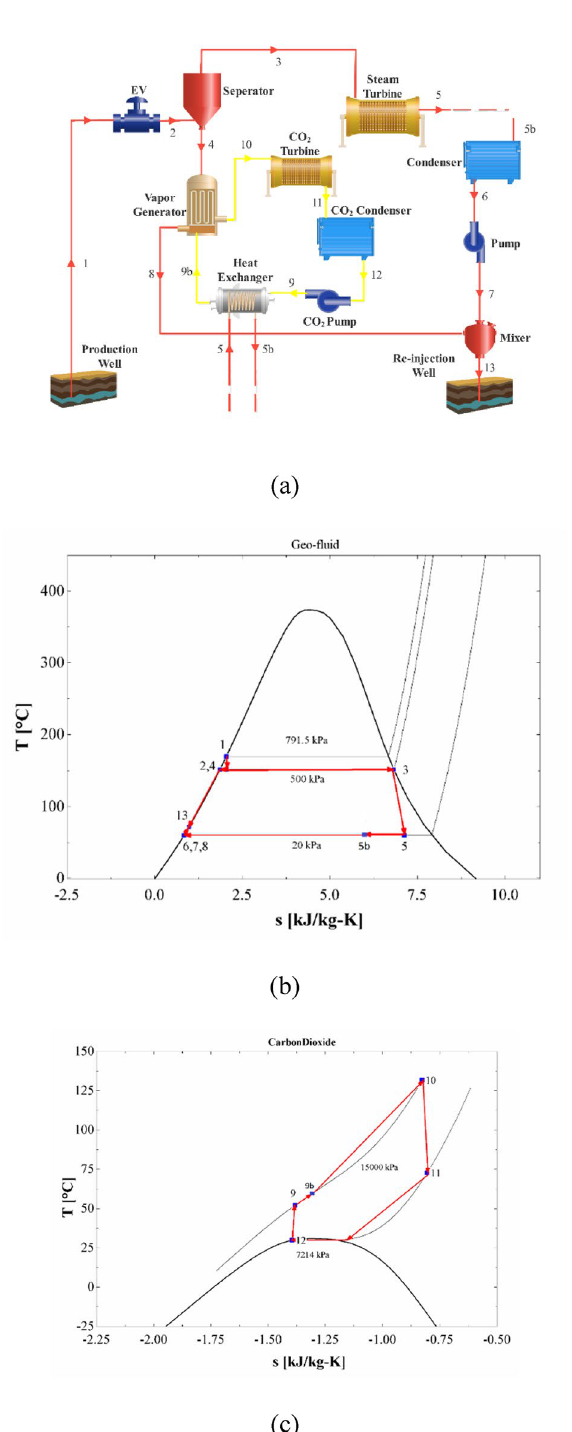
Fig. 3 a Schematic b , c T-s diagrams of single flash geothermal power plant powered by a trans-critical CO 2